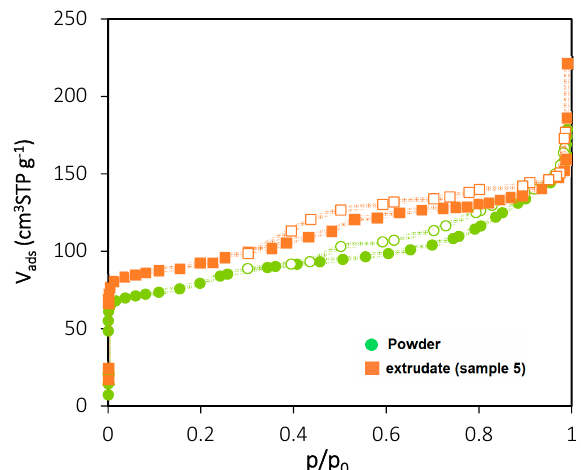
Figure 5. N 2 adsorption isotherms at 77 K for ZSM-5 pristine powder ( ■ ) and extrudate sample 5 ( ● ). The filled and empty symbols denote adsorption and desorption data, respectively.